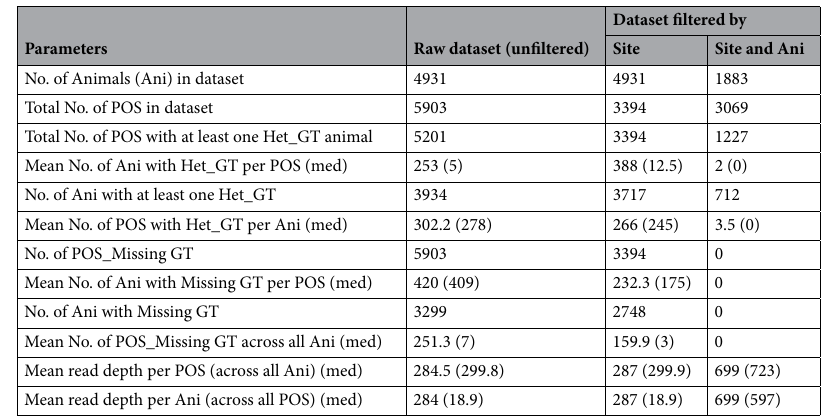
Table 2. Summary of the parameters of raw and filtered variant datasets before and after removing of sites with missing data (Site) and removing both sites and animals with missing data (Site & Ani). Ani animal, POS nucleotide position, GT genotype, Het_GT heteroplasmic genotype, med median.